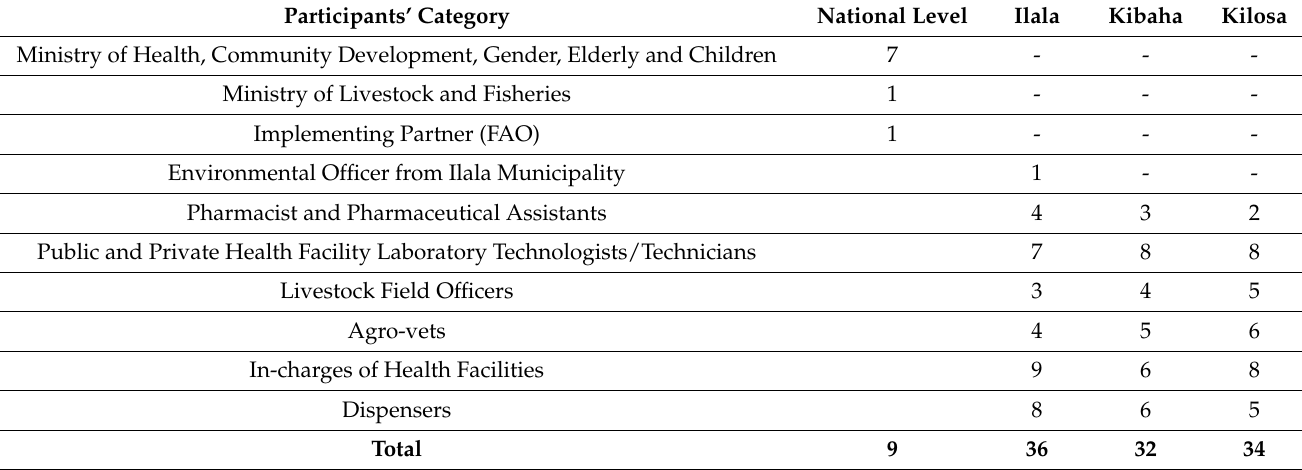
Table 1. Category and numbers of key